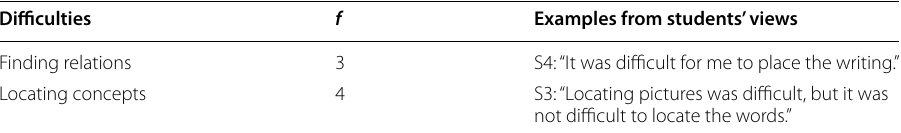
Table 4 Difficulties when using AR